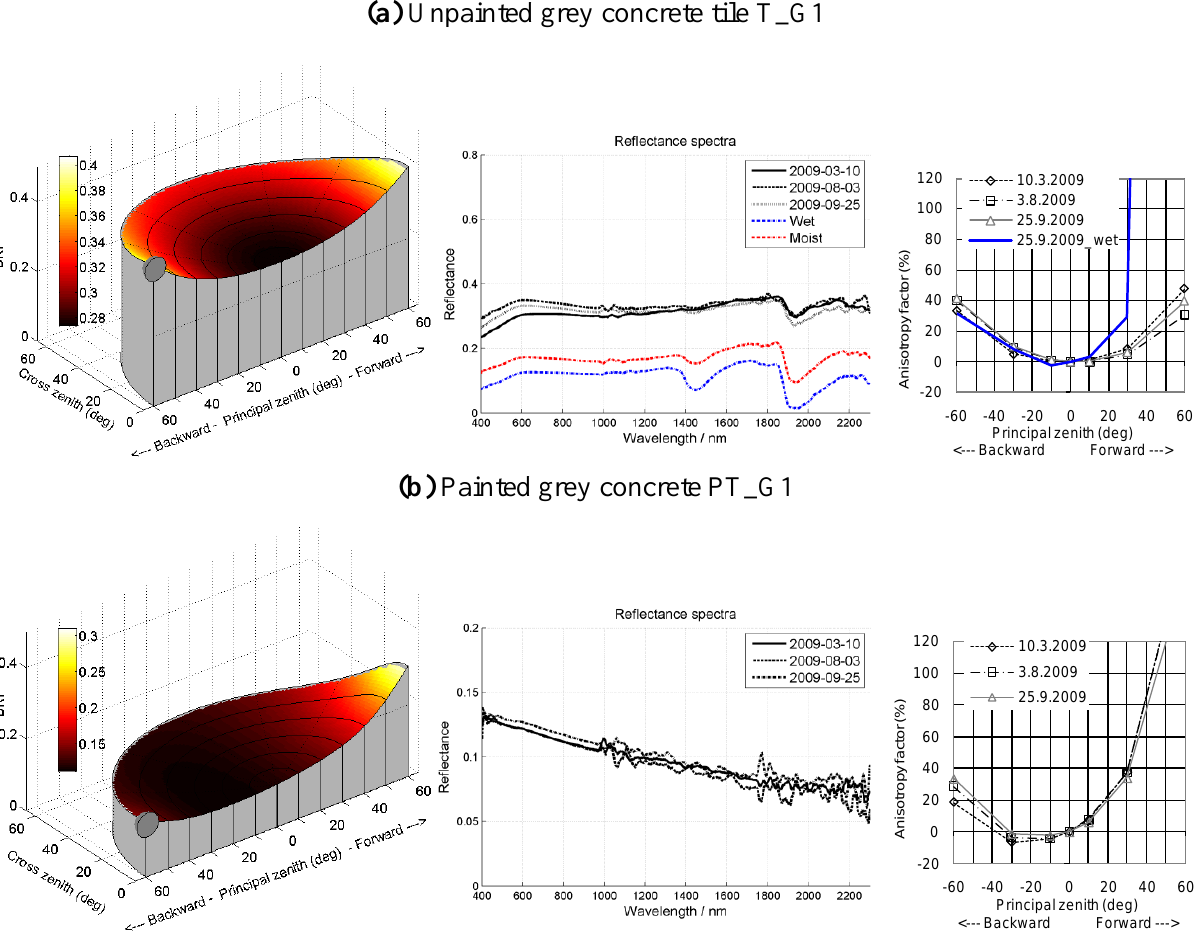
Figure 6. Reflectance characterization of concrete tiles: (a) unpainted grey T_G1, (b) painted grey PT_G1, (c) painted white PT_W1 and (d) unpainted red T_R, as in Figure 5. (a) Unpainted grey concrete tile T_G1